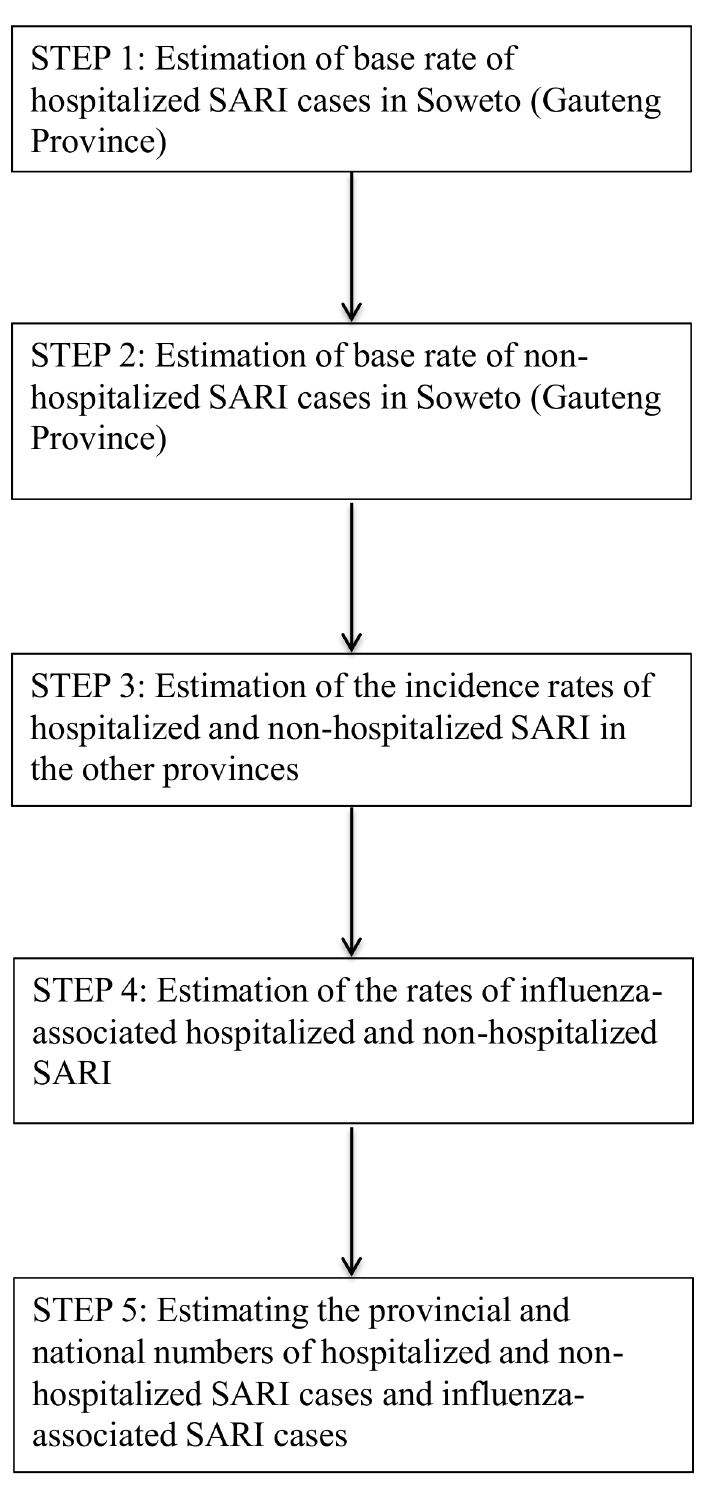
Fig 1. Flow diagram of methods. Visual depiction of the method used to calculate the rates and numbers of hospitalized and non-hospitalized SARI and influenza-associated SARI cases in of South Africa.